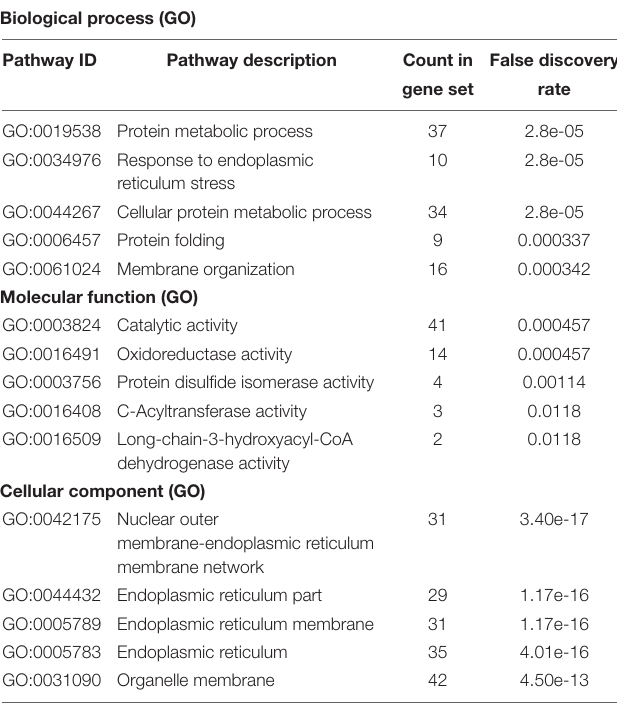
TABLE 3 | Gene ontology (GO) analysis of 84 CB2 specific interactors (including CB2) using the STRING database